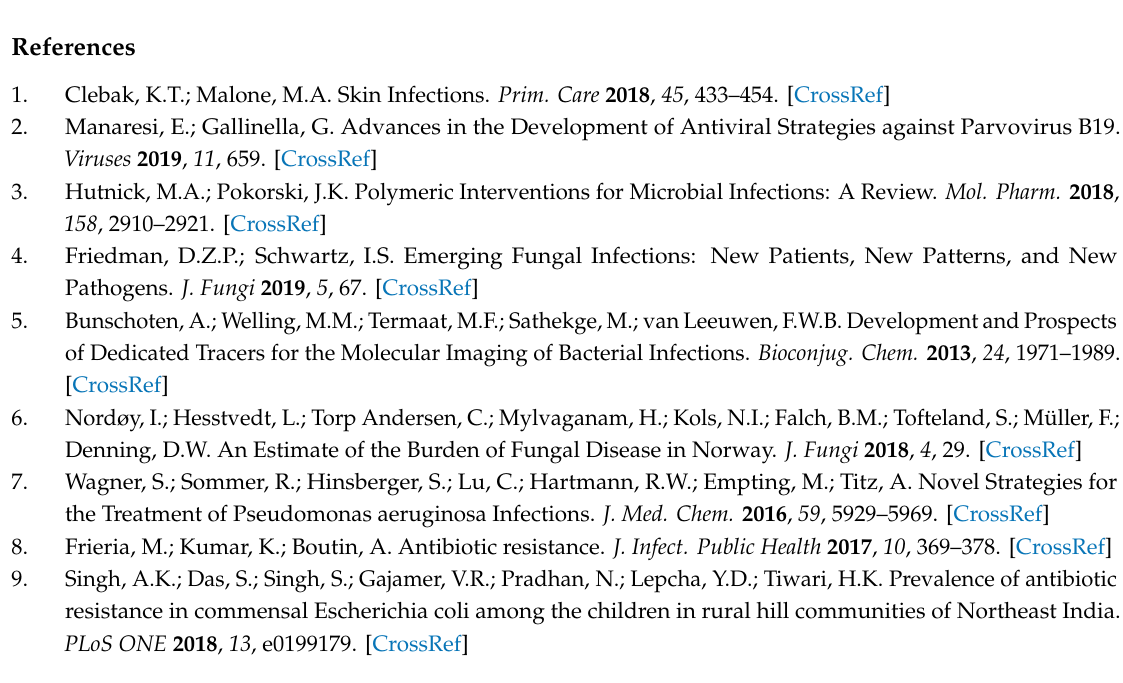
Figure S1: ( a ) Synthetic scheme for AgNPs-3MPS; ( b ) Uv-vis spectrum of AgNPs-3MPS in water with SPR at > = 8 ± 3 nm of AgNPs-3MPS in water; ( d ) ζ -potential = − 35 ± 2 mV of AgNPs-3MPS in λ = 425 nm; ( c ) < 2R H water; Figure S2: Calibration curve of AgNPs; SI Details about Small angle X-ray Scattering